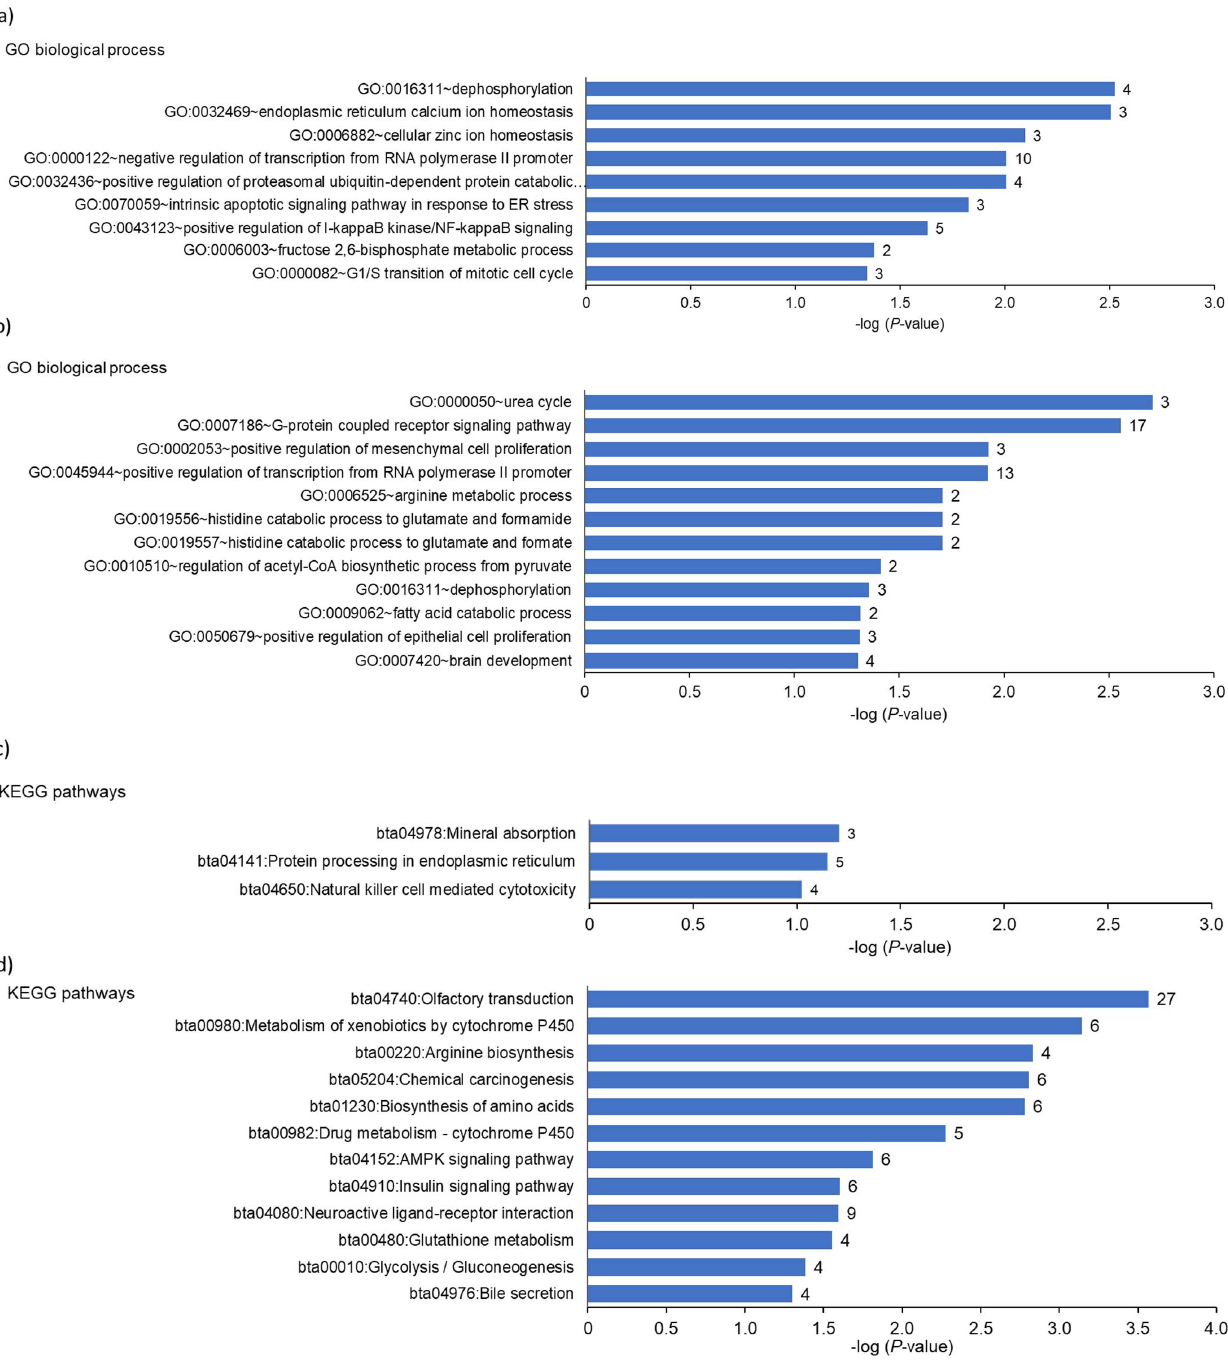
Figure 3. Enriched gene ontology (GO) biological process ( a , b ) and KEGG pathways ( c , d ) terms assigned to the differentially regulated transcripts between cows with high and low hepatic FGF21 expression at week 1 postpartum. GO terms and KEGG pathways are sorted by their enrichment p -values (EASE score) (top: lowest p -value, bottom: highest p -value). The number of genes is shown next to the bars.